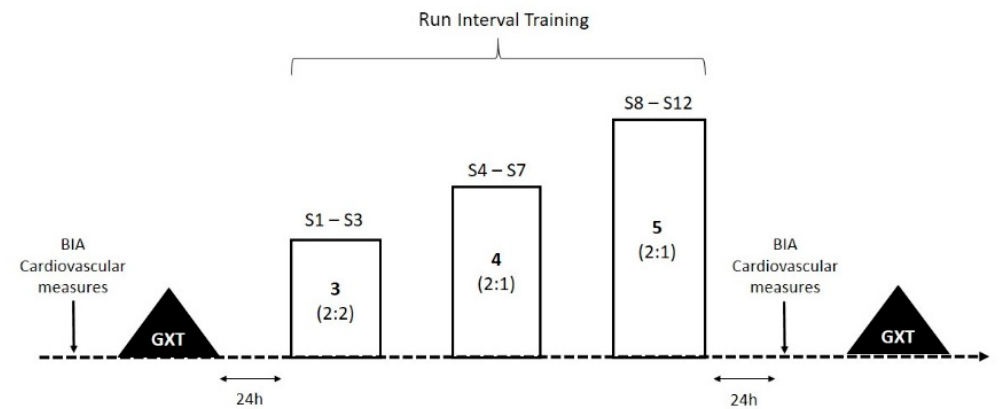
Figure 1. Flow chart of study procedures. Training sessions are depicted as open bars and the numbers inside bars indicate the interval ratio (high–low intensity) and bold numbers represent the 2 min “all out” sprints performed during each session. Cardiovascular measures, bioelectrical impendence (BIA) and graded exercise tests (GXT) were performed 24 h before and after the RIT protocol.